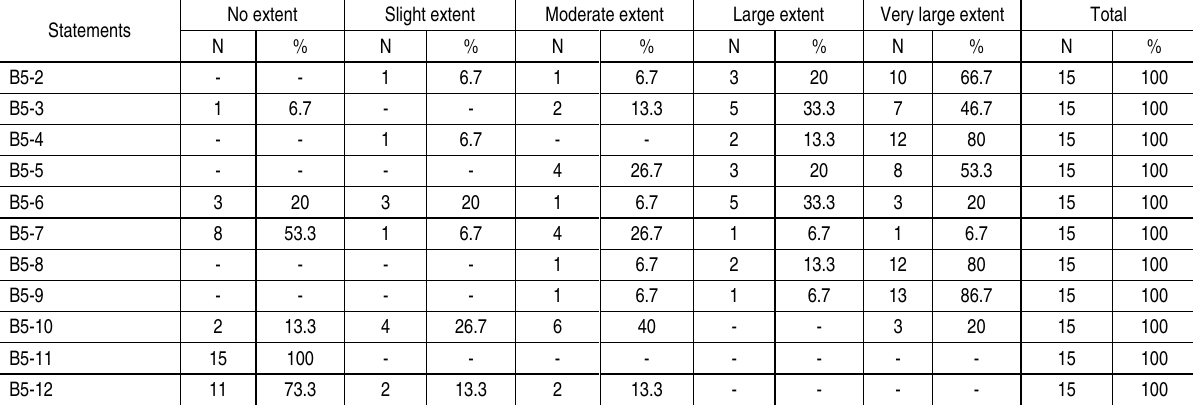
Table 4 (cont.). Perception of the respondents on the statement regarding acquisition management